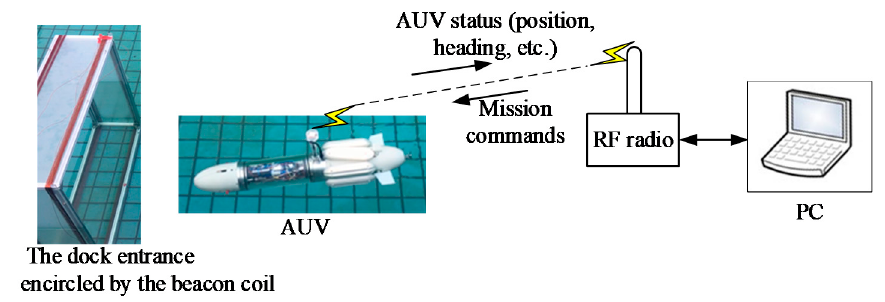
Figure 18. Docking experimental setup.